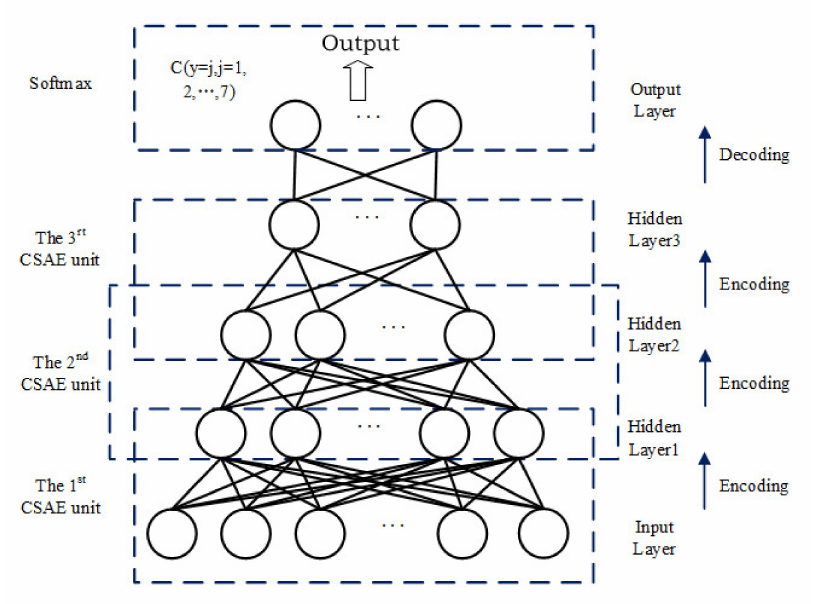
Figure 2. The structure of the